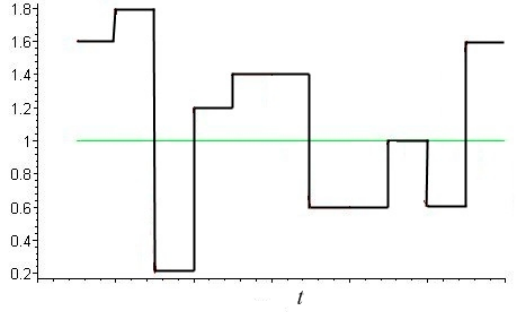
Figure 2. Example of stochastic variation of nominal pressure under frictional contact.